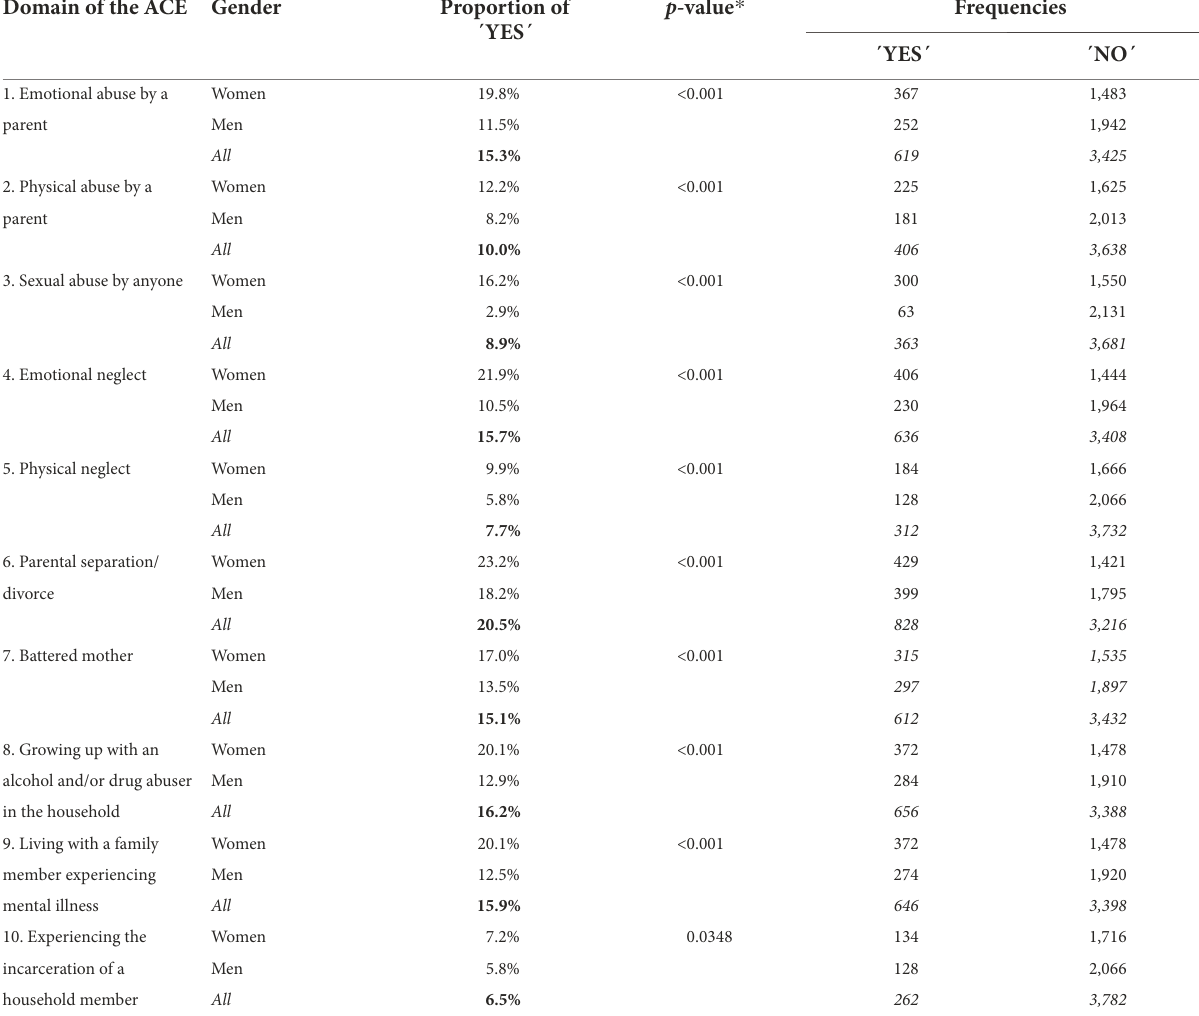
TABLE 3 ACE results according to the type and gender. Domain of the ACE